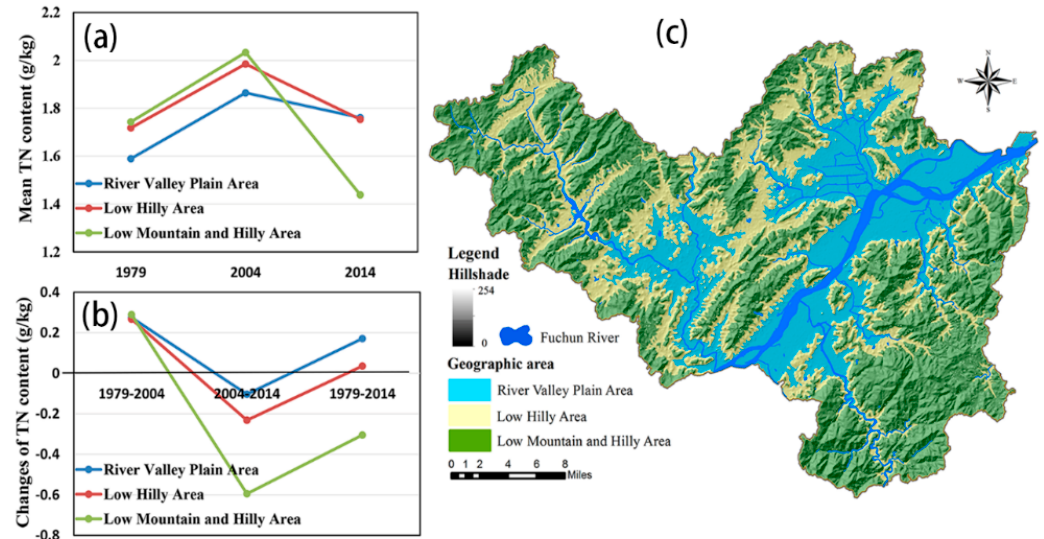
Figure 7. The average TN ( a ) and the changes in TN ( b ) in three geographic areas ( c ) were also analyzed in the present study to further understand the topographic effects on the spatiotemporal distributions of soil TN in cultivated lands.